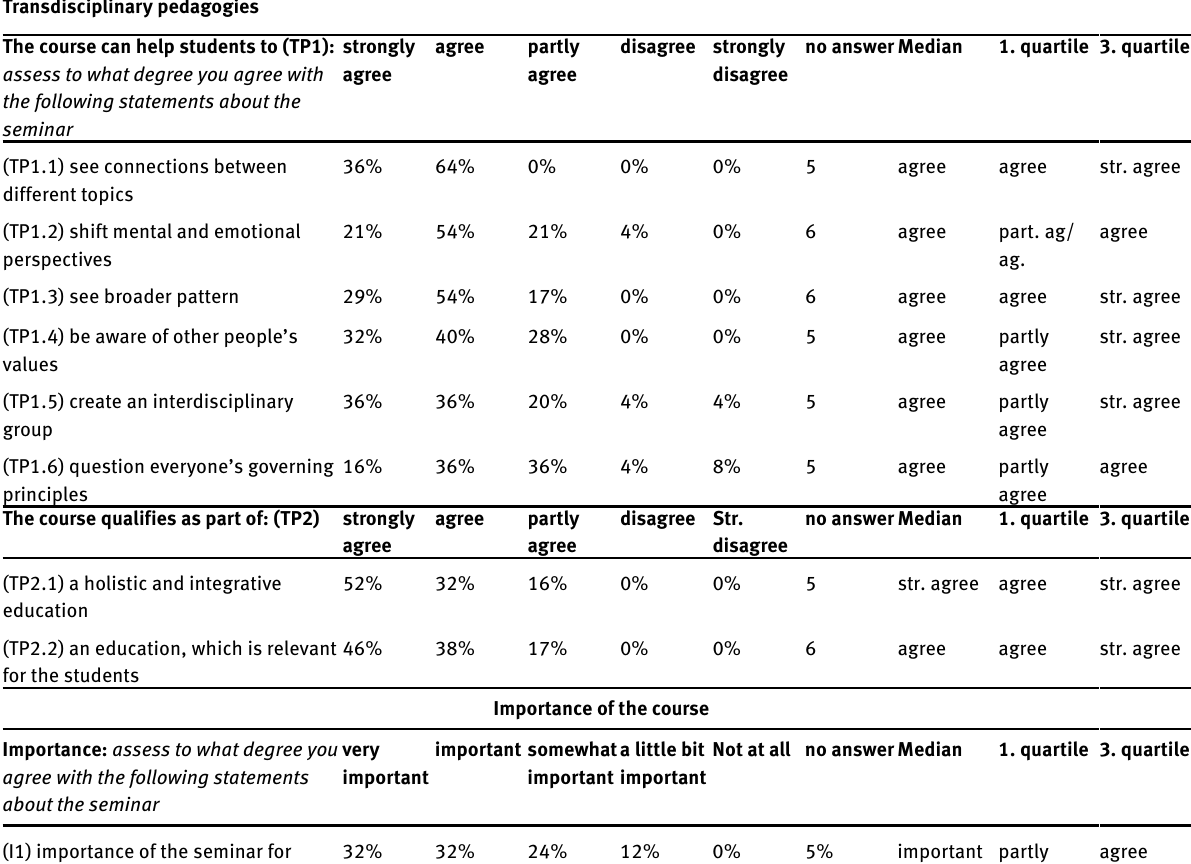
Table 5. Transdisciplinary pedagogies and importance of the course for further work Transdisciplinary